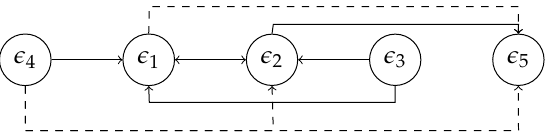
Figure 7. The actual causality diagram of the simulated benchmark.